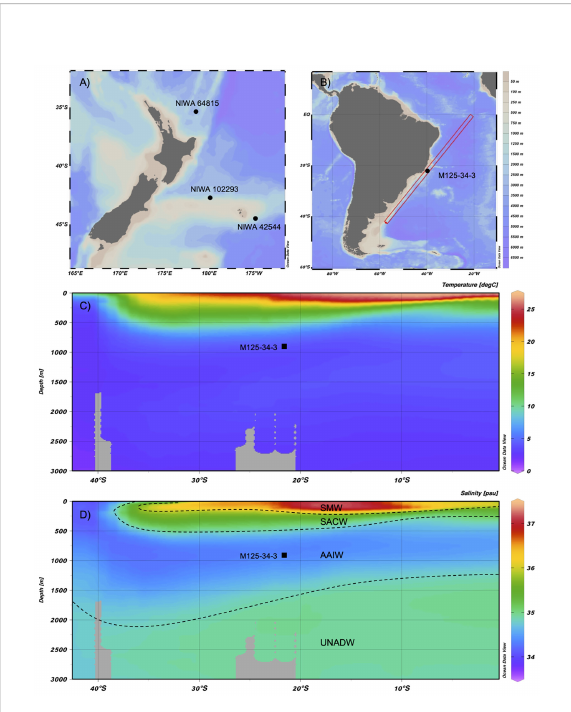
FIGURE 1 Map of the sampling locations: (A) live samples locations off New Zealand and (B) the location of the sediment core M125-34-3 off the coast of Brazil. (C) Temperature pro fi le and (D) salinity pro fi le of marked area in B, the black squares mark the position of the Bowie Mound (Schlitzer, 2021). The dashed lines show the boundary of the water masses from shallow to deep. These are: the salinity maximum waters (SMW), South Atlantic Central waters (SACW), Antarctic intermediate waters (AAIW) and Upper North Atlantic deep waters